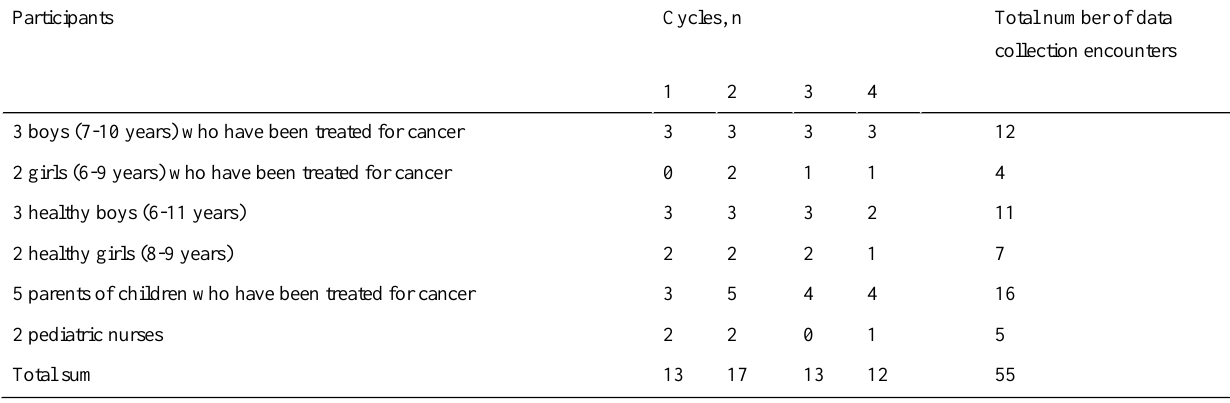
Table 2. Participants and the number of participants in each of the 4 cycles in the iterative low- and high-fidelity evaluation of Sisom.